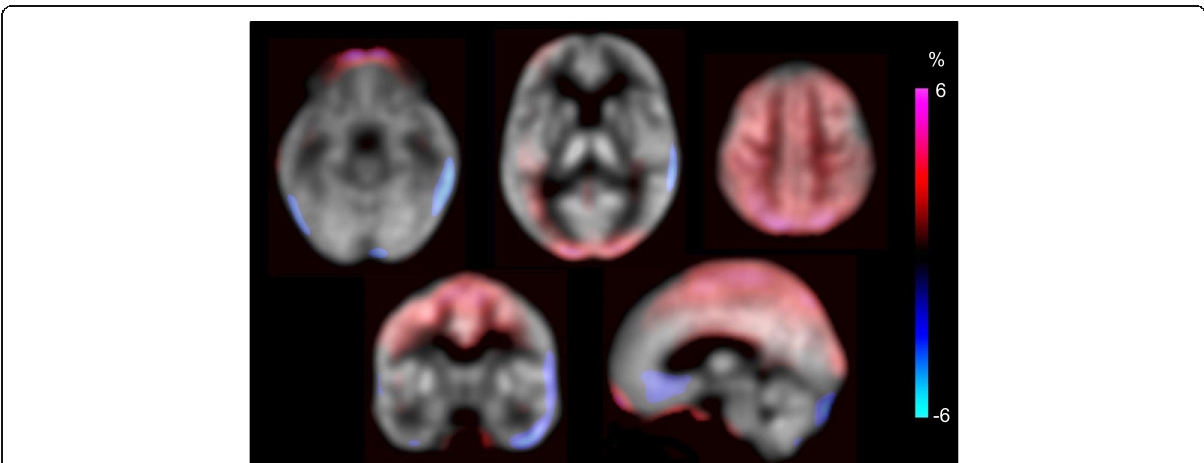
Fig. 6 Average image of percentage differences between AB- and ZTE-MRAC CBF calculated from all individual percentage change images. Red and blue indicate higher and lower values in the AB-MRAC method, compared with the ZTE-MRAC method, respectively. The parietal to occipital region shows higher CBF values with the AB-MRAC method compared with the ZTE-MRAC method, although the difference was less than 5%. Most of other brain regions showed very close regional CBF values, less than ±